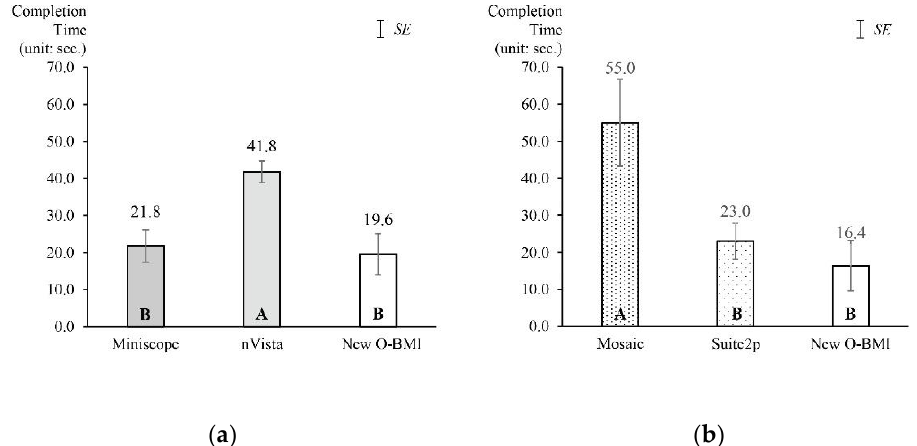
Figure 9. Comparison of O-BMI user interface designs in terms of task completion time. ( a ) video acquisition task; ( b ) signal extraction task.